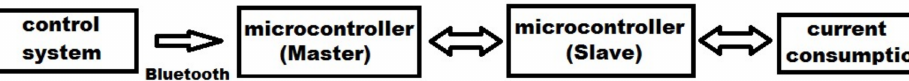
Figure 6. Block diagram of the control system.